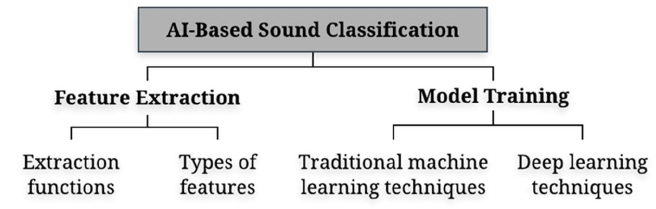
Figure 9. Main structure of AI-based sound classification. Table 4. Summary of acoustic features used in sound classification.